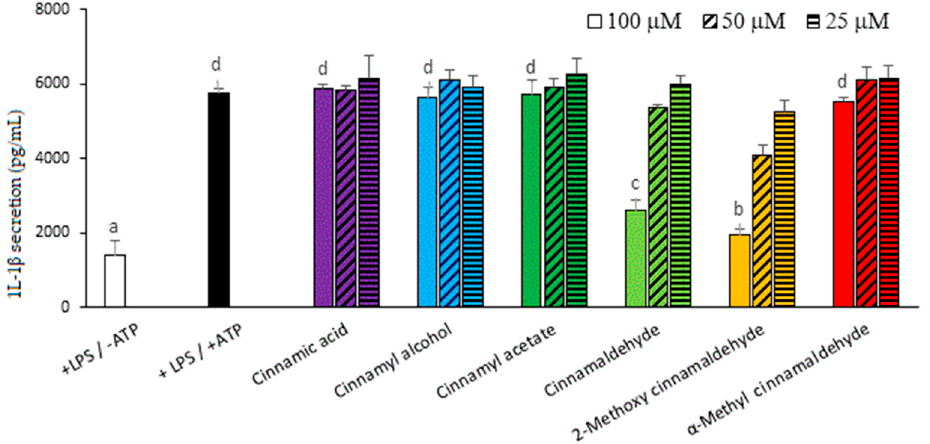
Figure 3. Influence of cinnamaldehyde-related compounds on ATP-induced IL-1 β secretion in LPS-primed cells. The LPS-primed macrophages were treated with 100 µ M cinnamaldehyde-related compounds for 30 min and then activated with ATP. Data are expressed as the mean ± SD and different superscript letters among 100 µ M treatment groups represent statistically differences ( p <